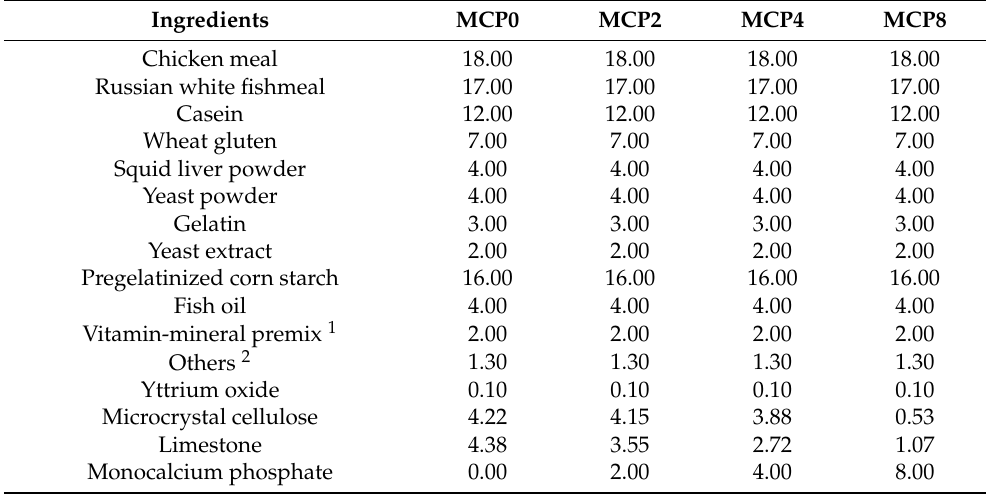
Table 1. Diet formulation and measured macronutrients of experimental diets (%, on DM